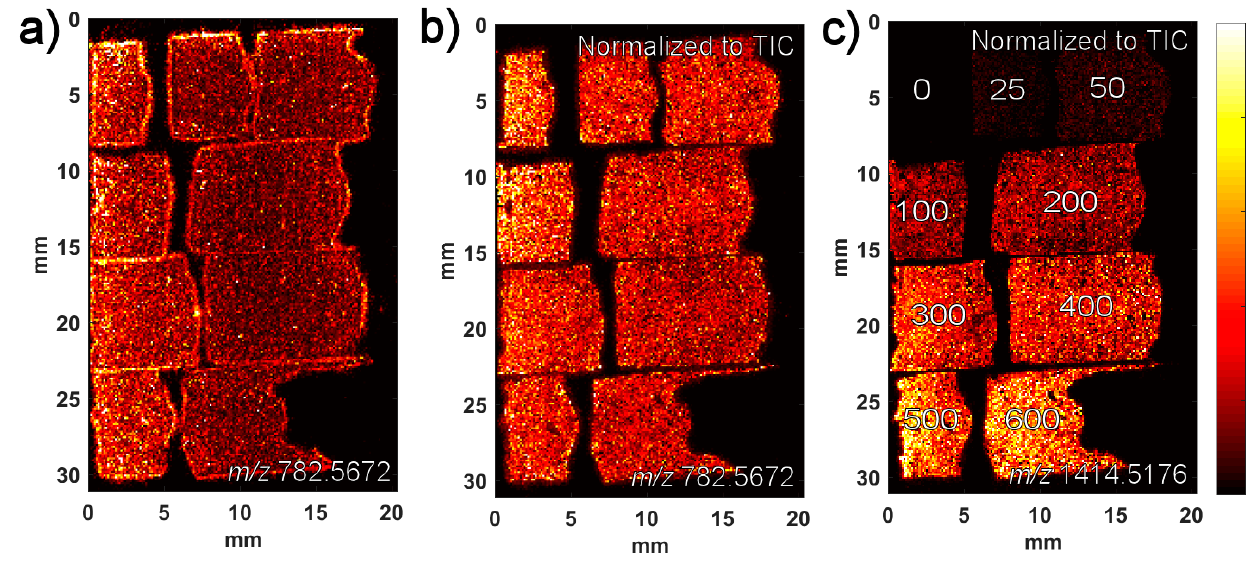
Figure 2. MALDI images of the mimetic tissue model. ( a ) PC(34:1) ( m/z 782.5672) with no normali- zation. ( b ) PC(34:1) ( m/z 782.5672) with normalization to TIC. ( c ) Bleomycin A2 ( m/z 1414.5176) with normalization to TIC.